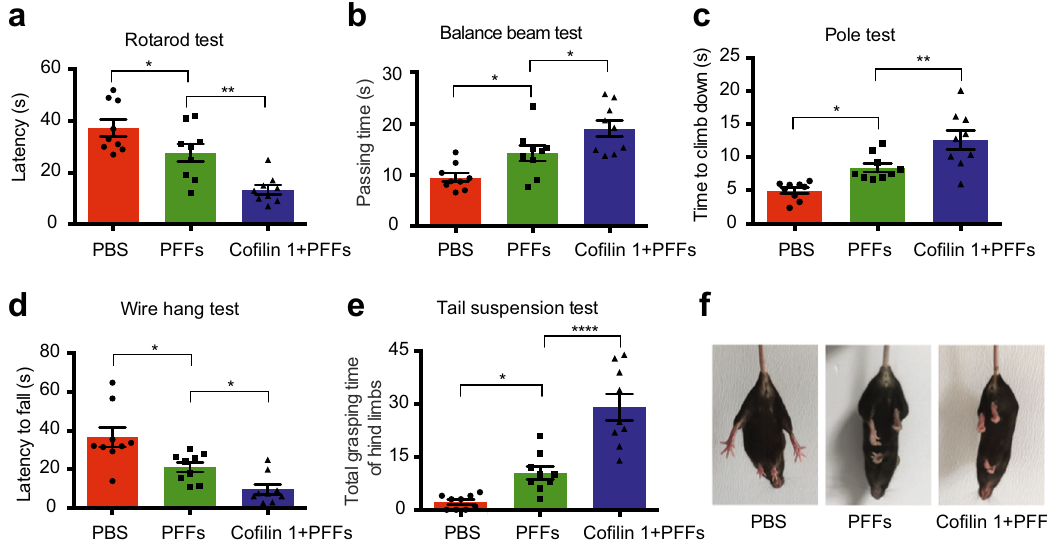
Fig. 6 Co fi lin 1 enhances behavioral impairments induced by α -synuclein fi brils. Behavioral performance. The behavioral impairments were more severe when co fi lin 1 was overexpressed with α -synuclein fi brils, as demonstrated by rotarod test ( a ), balance beam test ( b ), pole test ( c ), wire hang test ( d ), and tail suspension test ( e ). Data are mean ± SEM; n = 9 mice per group; * P < 0.05, ** P < 0.01, **** P < 0.0001 by one-way ANOVA. ( f ) Representative images showing the hindlimbs clasp in tail suspension